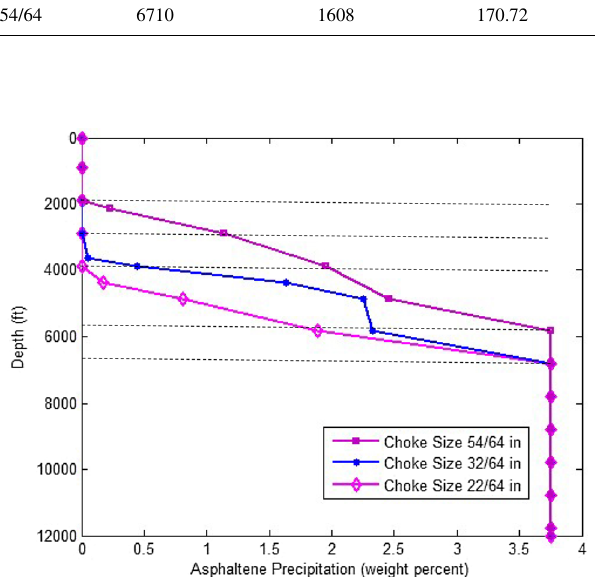
Fig. 20 Sensitivity analysis; effect of choke size on precipitation pro- file